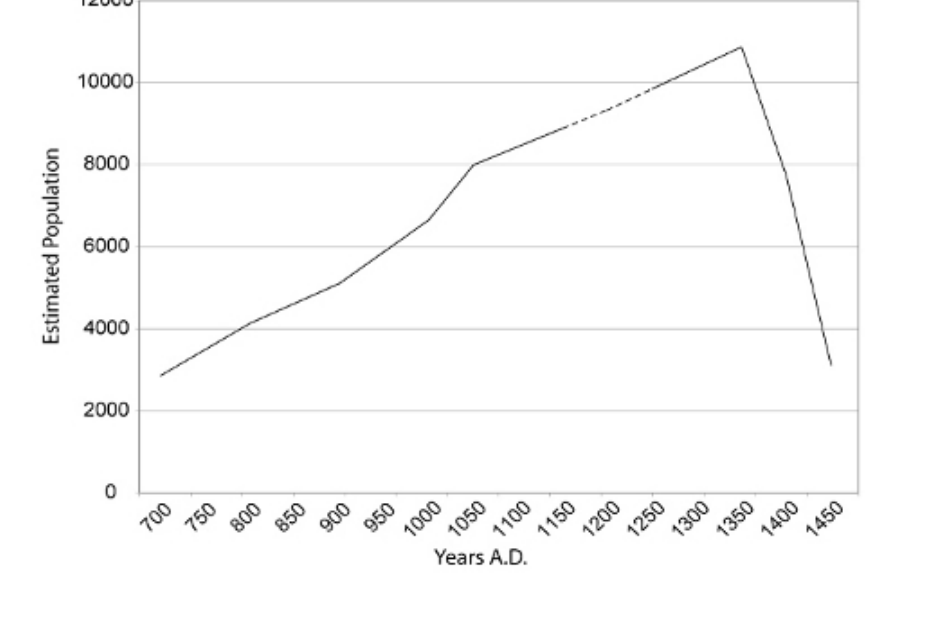
Fig. 10. Population growth in the Lower Salt River valley of the Hohokam region. Population estimates for the Hohokam region are primarily based on previous work by Doelle (1995, 2000), who estimated population by placing all large sites across the region into a number of site size classes and defining a momentary population estimate for each size class based on the best-known examples in each category. He then used the existing information from archaeological surveys across the region to estimate roughly what proportion of the sites in a given time period are likely known. This information was used to create conversion factors that attempt to account for sites missing from the database. We used Doelle’s original procedures, but incorporated new information on specific sites and time periods into the database, altering the previously published estimates. The dotted portion of the line represents a time period for which there are few data. For our purposes, we assumed that the population increased gradually during this time to the levels estimated for the better-known period at around AD